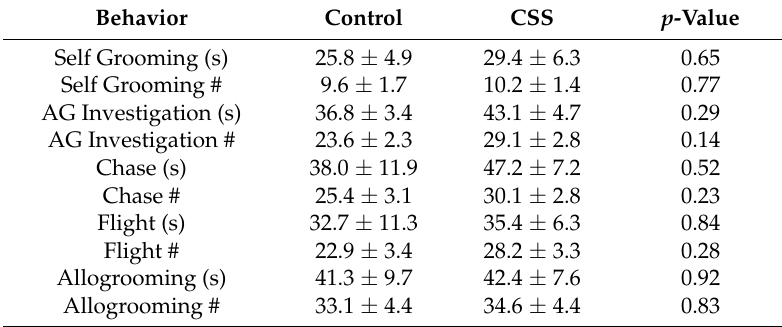
Table 3. Mean ± SEM durations (s) and frequencies (#) of behaviors displayed by control and CSS F1 juvenile females during a 15 min social behavior test with p -value results from 2-tailed t -tests.